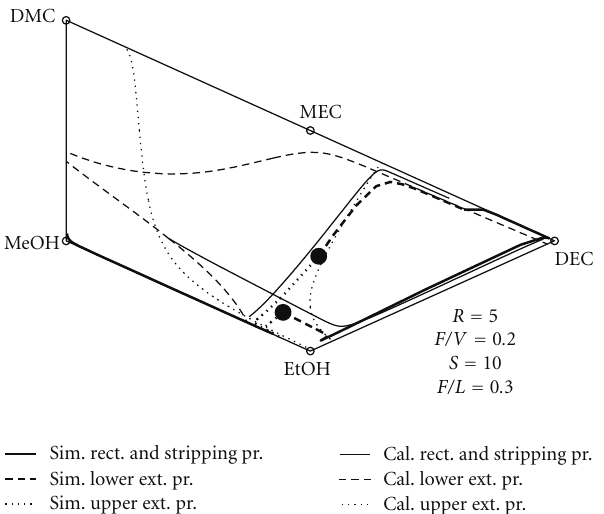
Figure 13: Simulated and calculated profiles during the feasibility study at R = 5, at F d /V = 0 . 2, at S = 10 and at F w /L = 0 . 3.